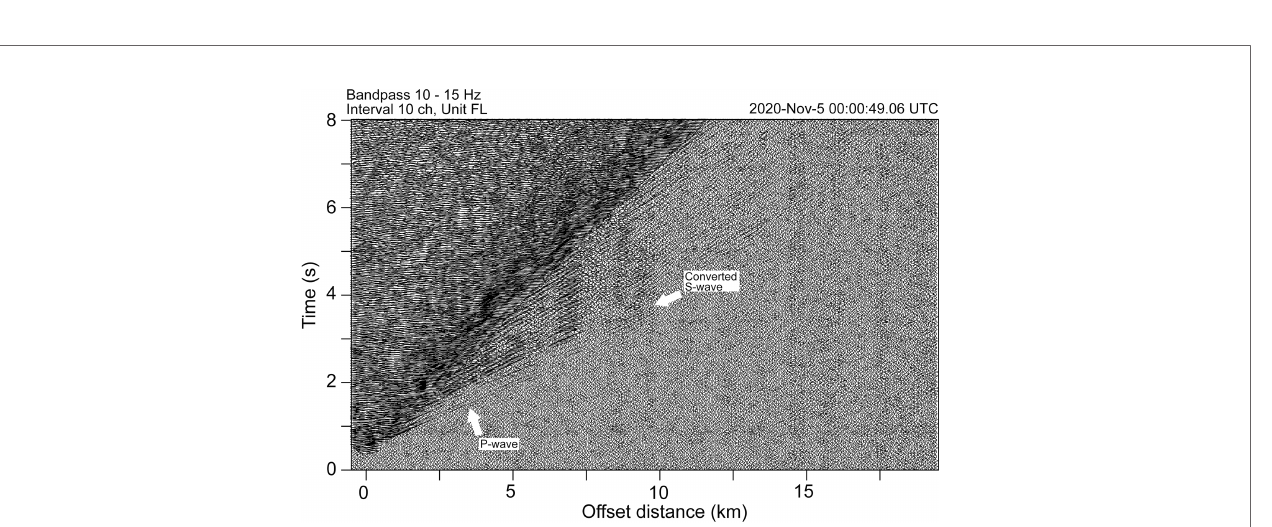
FIGURE 11 | Time – distance pro fi le of the airgun shooting (common shot gather) obtained by a DAS interrogator. To increase the S/N ratio, adjacent 10 traces were averaged, and the bandpass fi lter was applied. Before the arrivals of the water waves, the arrivals of the refraction waves are clearly seen up to offset distances greater than 10 km. The fi rst arrivals have an apparent velocity of approximately 3.6 km/s. Later arrivals, which were interpreted as converted S-waves, have a larger amplitude than the fi rst